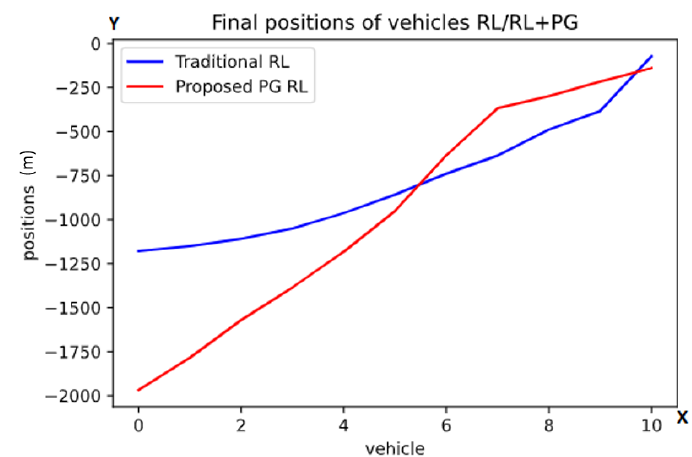
Figure 3. Graph of the finals positions after the first task using the traditional RL (blue color) and the proposed PG RL (red color) models. The y -axis is representing the position behind the lead vehicle in meters while one point on the x -axis is referring to exactly one vehicle. These are the average final positions at the end of the scenarios, with the numbers referring to the vehicles (from back to front).